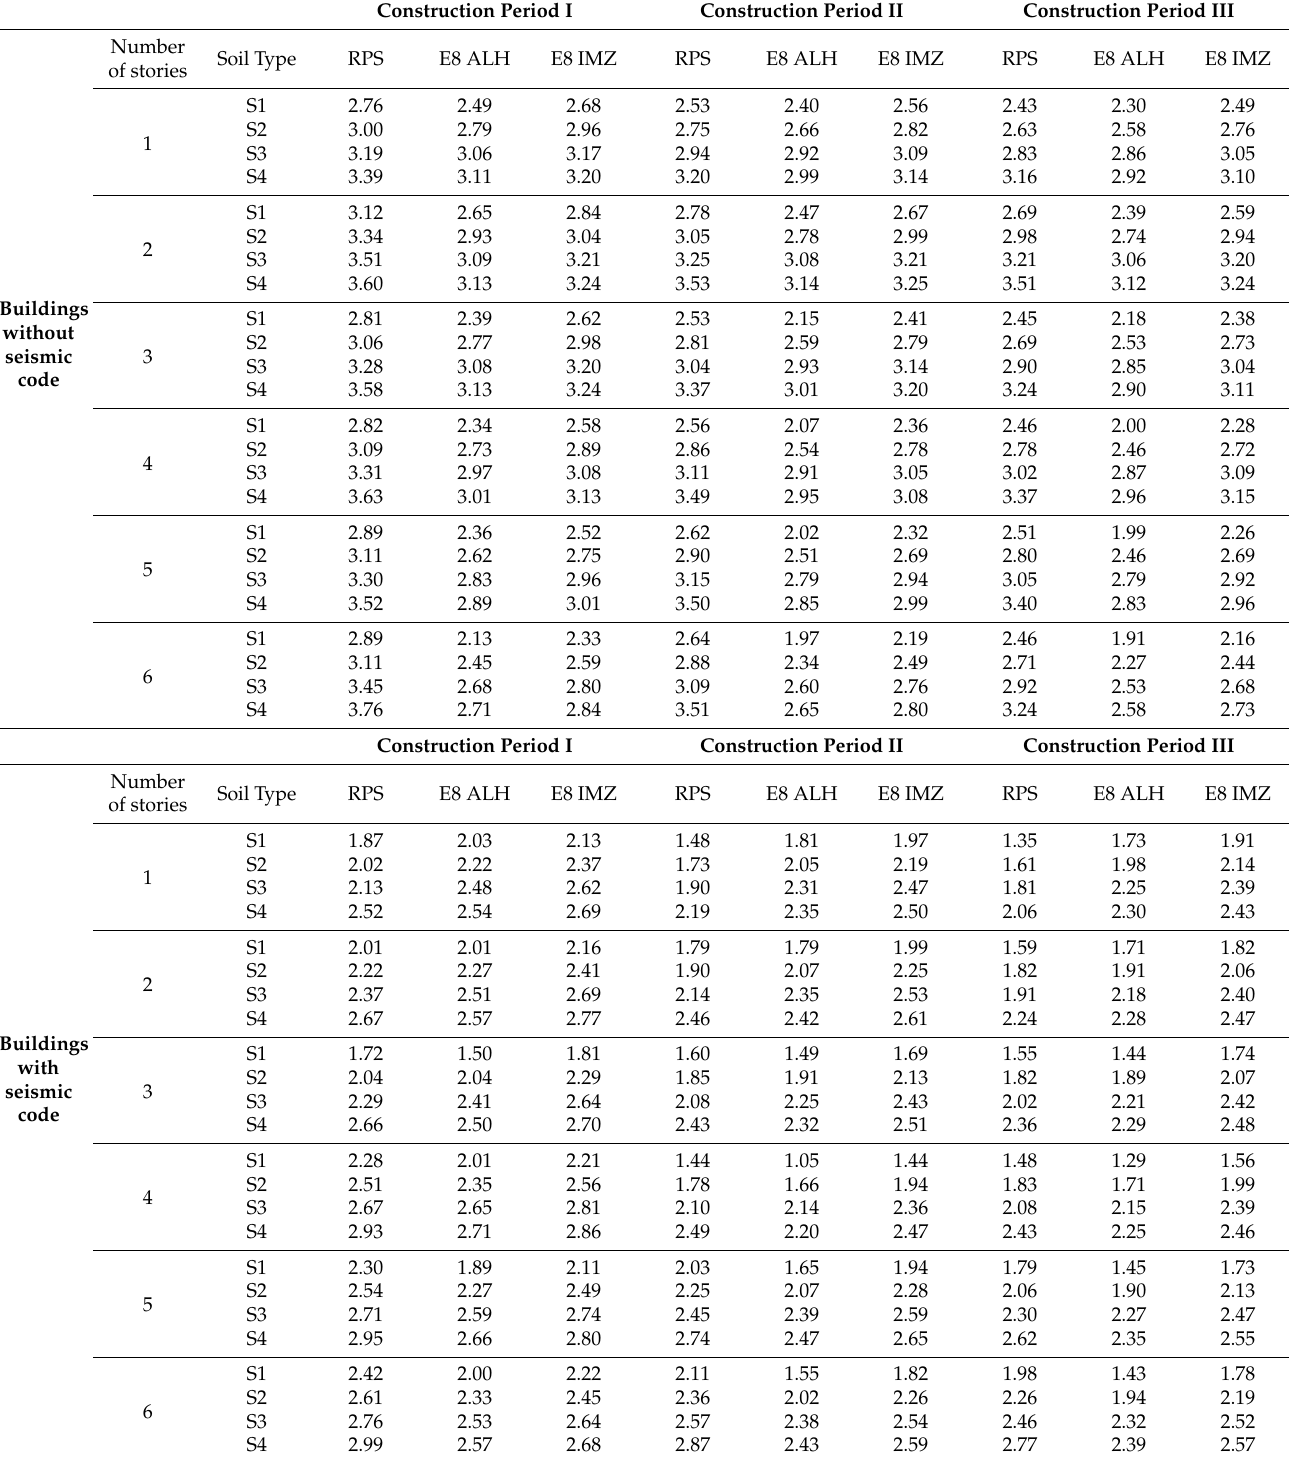
Table A5. Damage index DS m values for the RC building models according to both probabilistic scenarios (RPS2000 and Eurocode